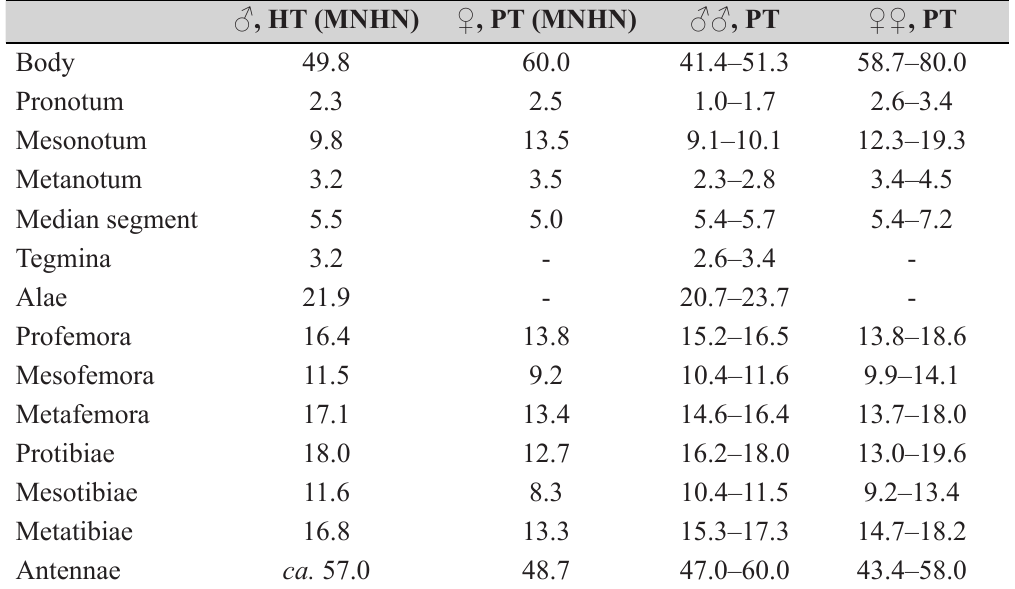
Table 12 . Measurements of Phantasca ruboligata sp. nov. (in mm). HT = Holotype; PT =